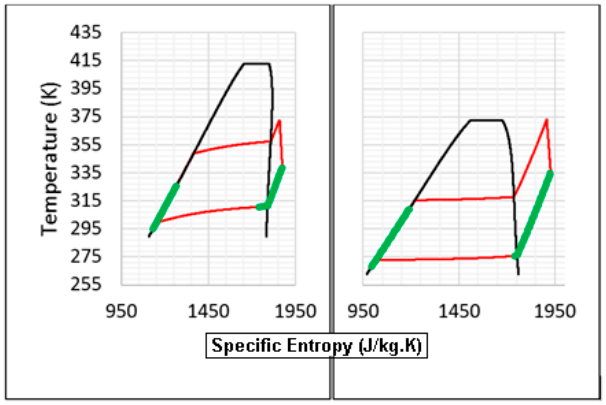
Figure 6. Comparison of dynamic Organic Rankine Cycles operating under high temperature (290 K, left ) and low temperature (265 K, right ) ambient conditions.